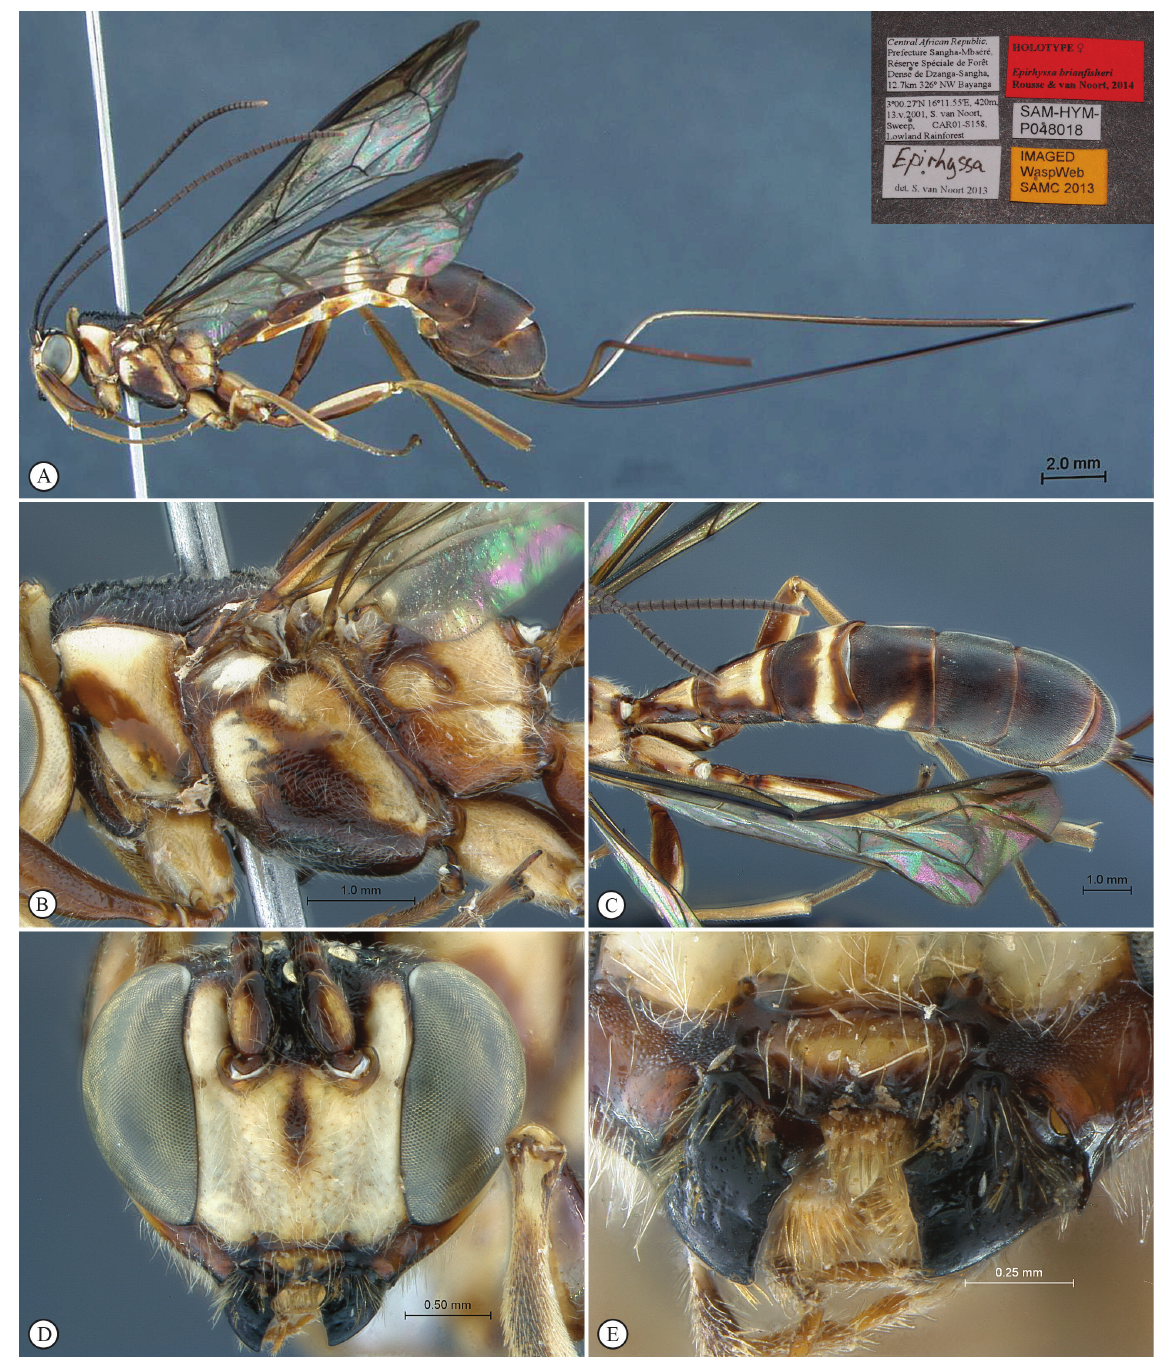
Fig. 1. Epirhyssa brianfisheri sp. nov., holotype, ♀. A . Habitus, lateral view (inset: data labels). B . Mesosoma, lateral view. C. . Metasoma, dorsal view. D . Head, anterior view. E . Mandibles, anterior